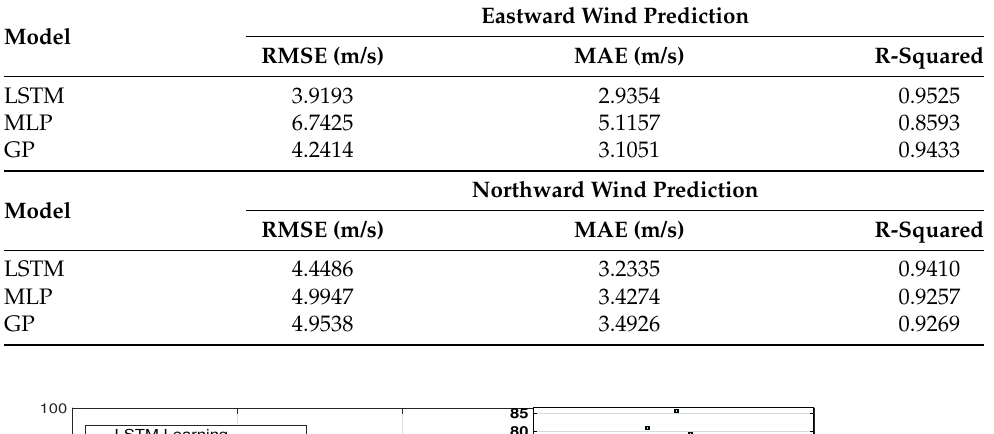
where M is the number of data for this validation phase. The results are tabulated in Table 3. We also calculated the prediction errors ( = ˆ x i − x i ) and uncertainty bounds of the models as shown in Figure 5. The results from Table 3 and Figure 5 indicate that time-series wind datasets are best predicted by the LSTM network (e.g., smallest RMSE and MAE) compared to the other machine learning models (i.e., GP and MLP). Table 3. Comparison of machine-learning-based time-series wind prediction models. Model